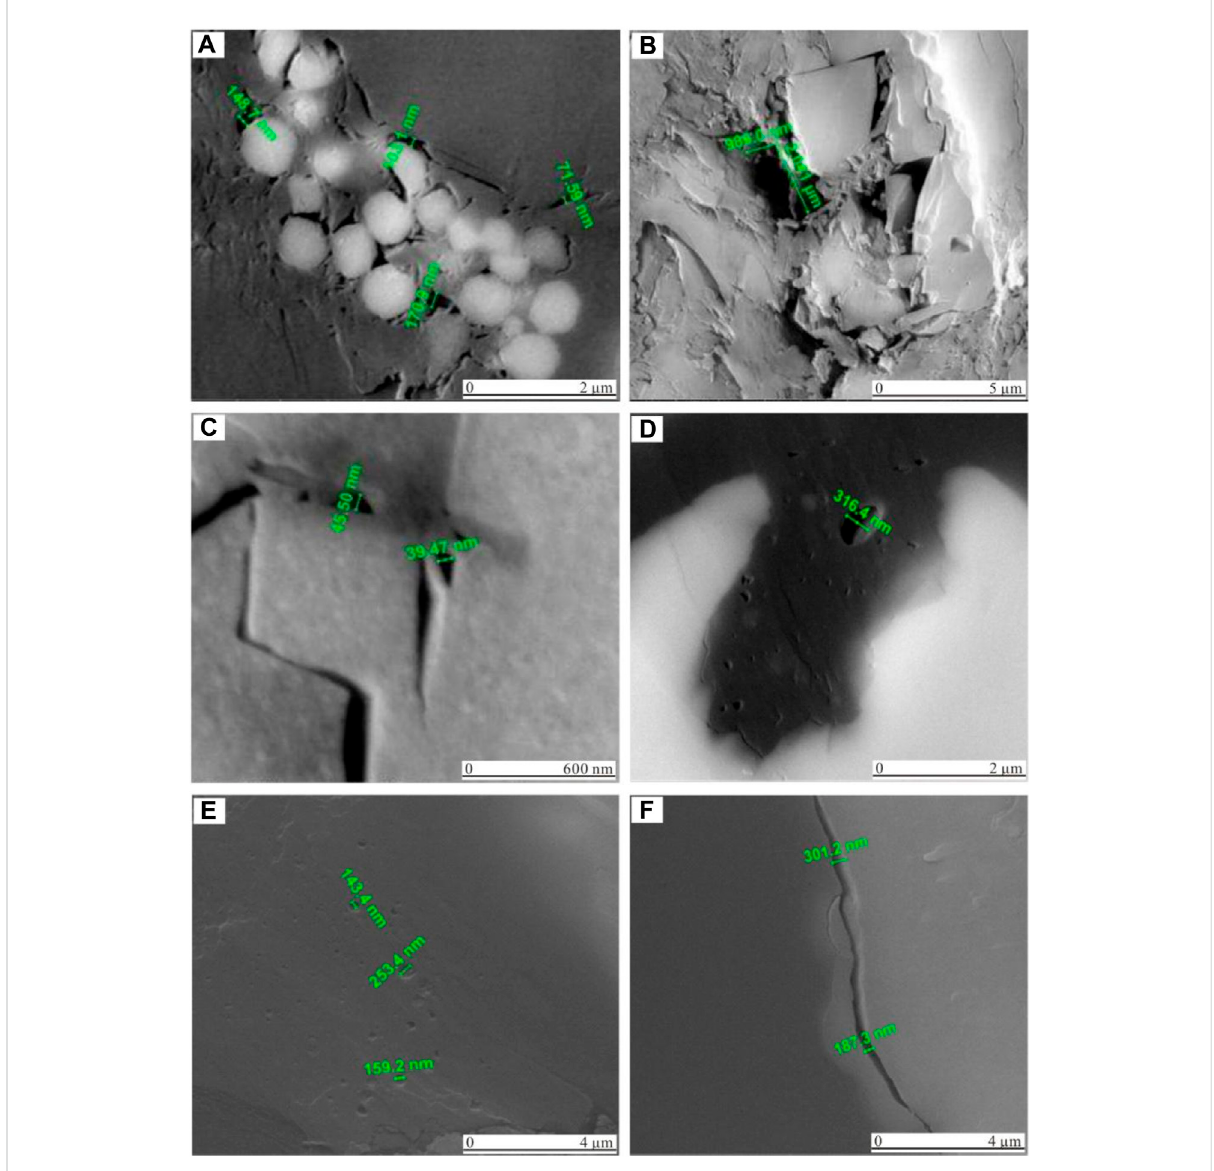
FIGURE 8 Microscopic images of pore characteristics of the Taiyuan and Shanxi Formation shales from Well MY1. (A) Pyrite intergranular pores, 2,934 m; (B) Intergranular pores, 2,937 m; (C) Calcite edge mold pores, 2,874 m; (D) Organic hydrocarbon generation pores, 2,944 m; (E) Organic hydrocarbon generation pores, 2,945 m; (F) Organic matter shrinkage crack, 2,948